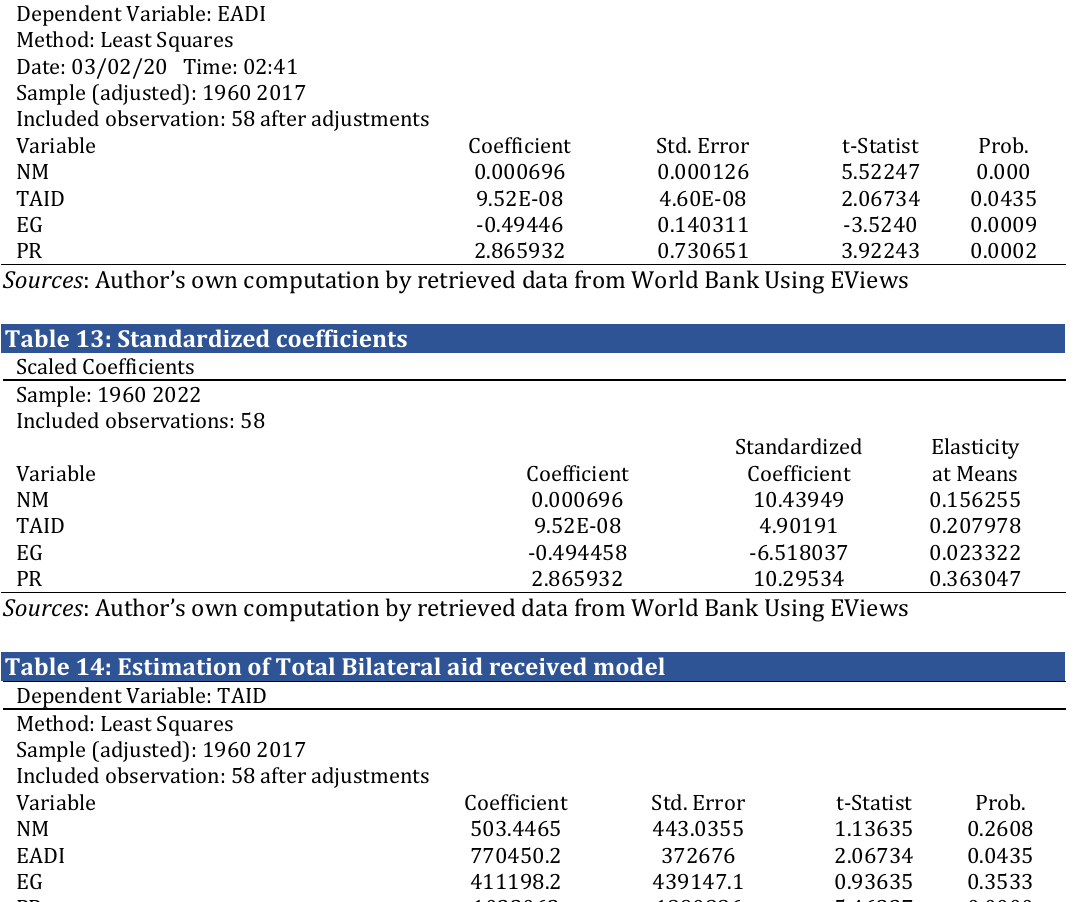
Table 12: Estimation of employment in agriculture Dependent Variable: EADI